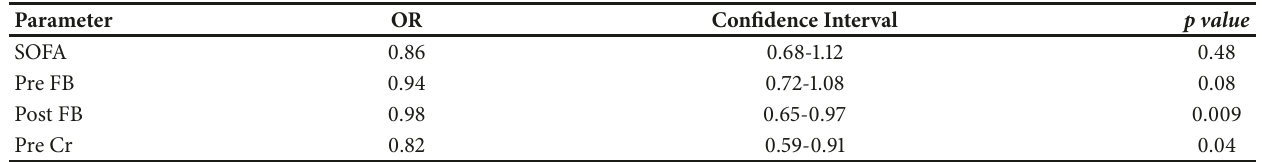
Table 8: Multivariate logistic regression of clinical and laboratory characteristics and dialysis complications associated with the recovery of renal function in patients with AKI treated with